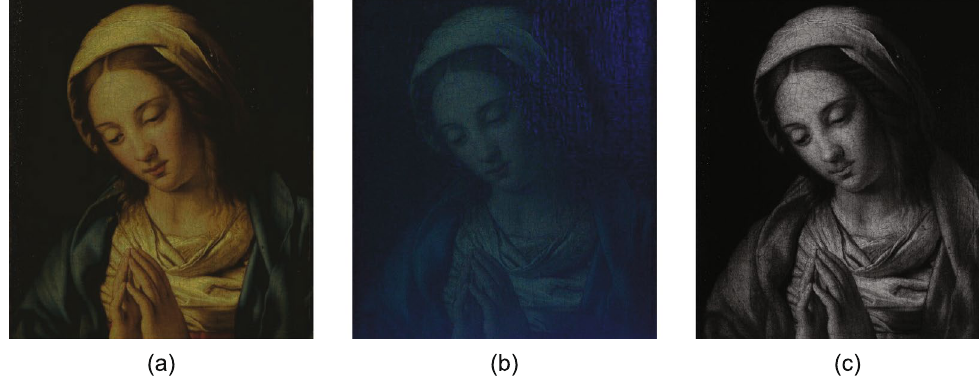
Figure 1. Images of Madonna in Preghiera . ( a ) Visible photograph of the Madonna in Preghiera ; ( b ) Image of Madonna in Preghiera obtained by UV Fluorescence; ( c ) Image of Madonna in Preghiera obtained by IR